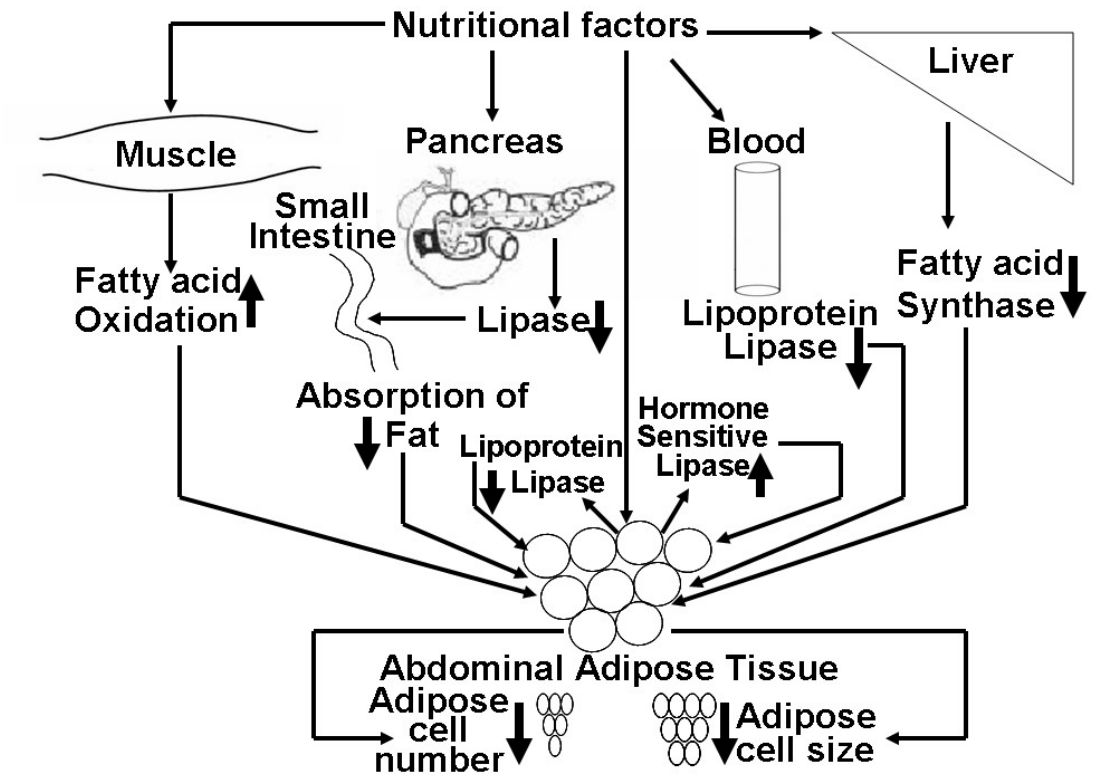
Figure 1. The mechanisms of nutritional factors that beneficially regulate abdominal fat deposition. Nutritional factors may: reduce fatty acid synthesis in the liver (the crucial site for fatty acid synthesis); suppress the secretion of pancreatic lipase, which reduces fat absorption; increase fatty acid β-oxidation in the muscles; inhibit the activity of lipoprotein lipase in the blood or abdominal adipose tissue; and/or enhance the activity of hormone-sensitive lipase in abdominal adipose tissue, which finally leads to a reduction in abdominal adipose tissue by decreasing the size and/or number of abdominal adipose cells. ↑, enhanced; ↓,